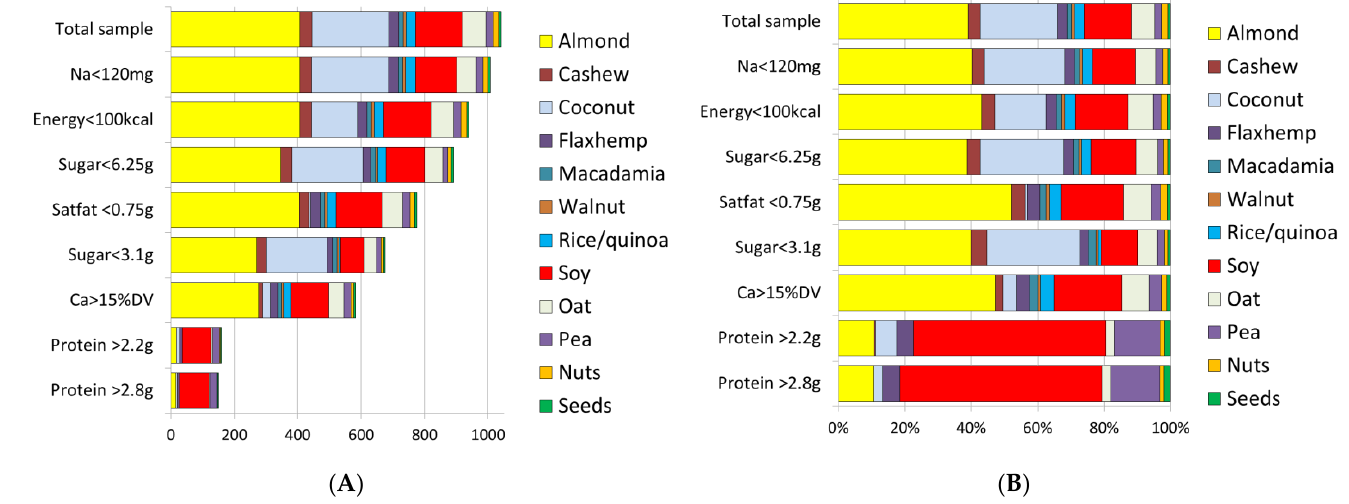
Figure 3. The number ( A ) and percent distribution of PB milk alternatives ( B ) that met the proposed nutrient standards by main ingredient.